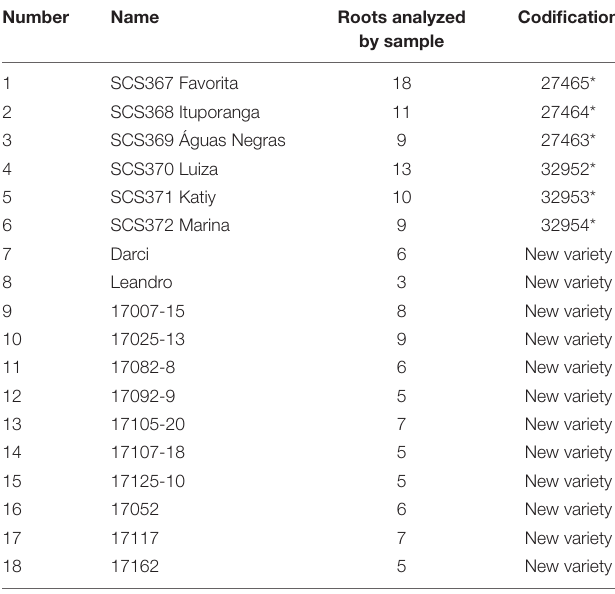
TABLE 1 | New sweet potato varieties and registered